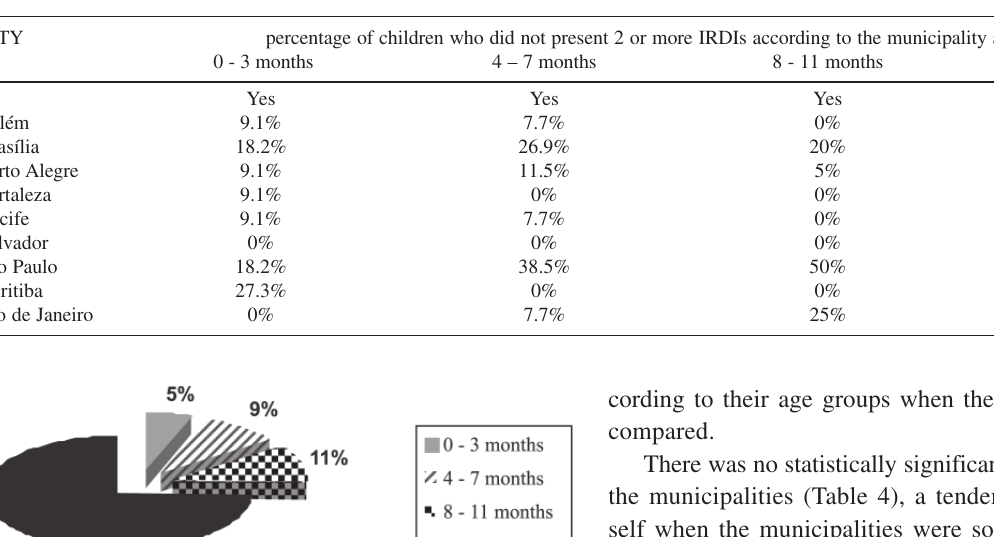
Table 3 - Children who did not present 2 or more IRDI distributed according to different age groups (0-3 months; 4 – 7 months; 8 – 11 months and 12 –18 months) and municipality.